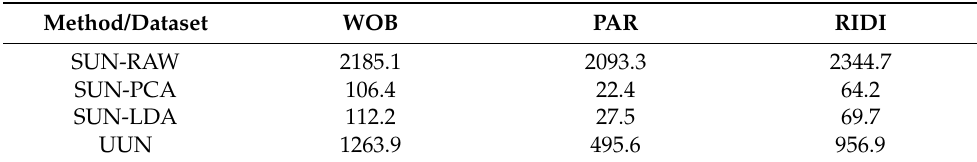
Figure 4. UUN feature representation. ( A ) Training representation, ( B ) Inference representation. t-SNE is performed in order to convert to a lower dimension and to visualize the clusters. This figure shows that latent space exhibits structure. The different colored labels obviously cluster in different parts of the UUN feature space. t-SNE axes 1, 2, and 3 represent dimension 1, 2, and 3, respectively. Table 7. Inference average time [sec] on different testing datasets.